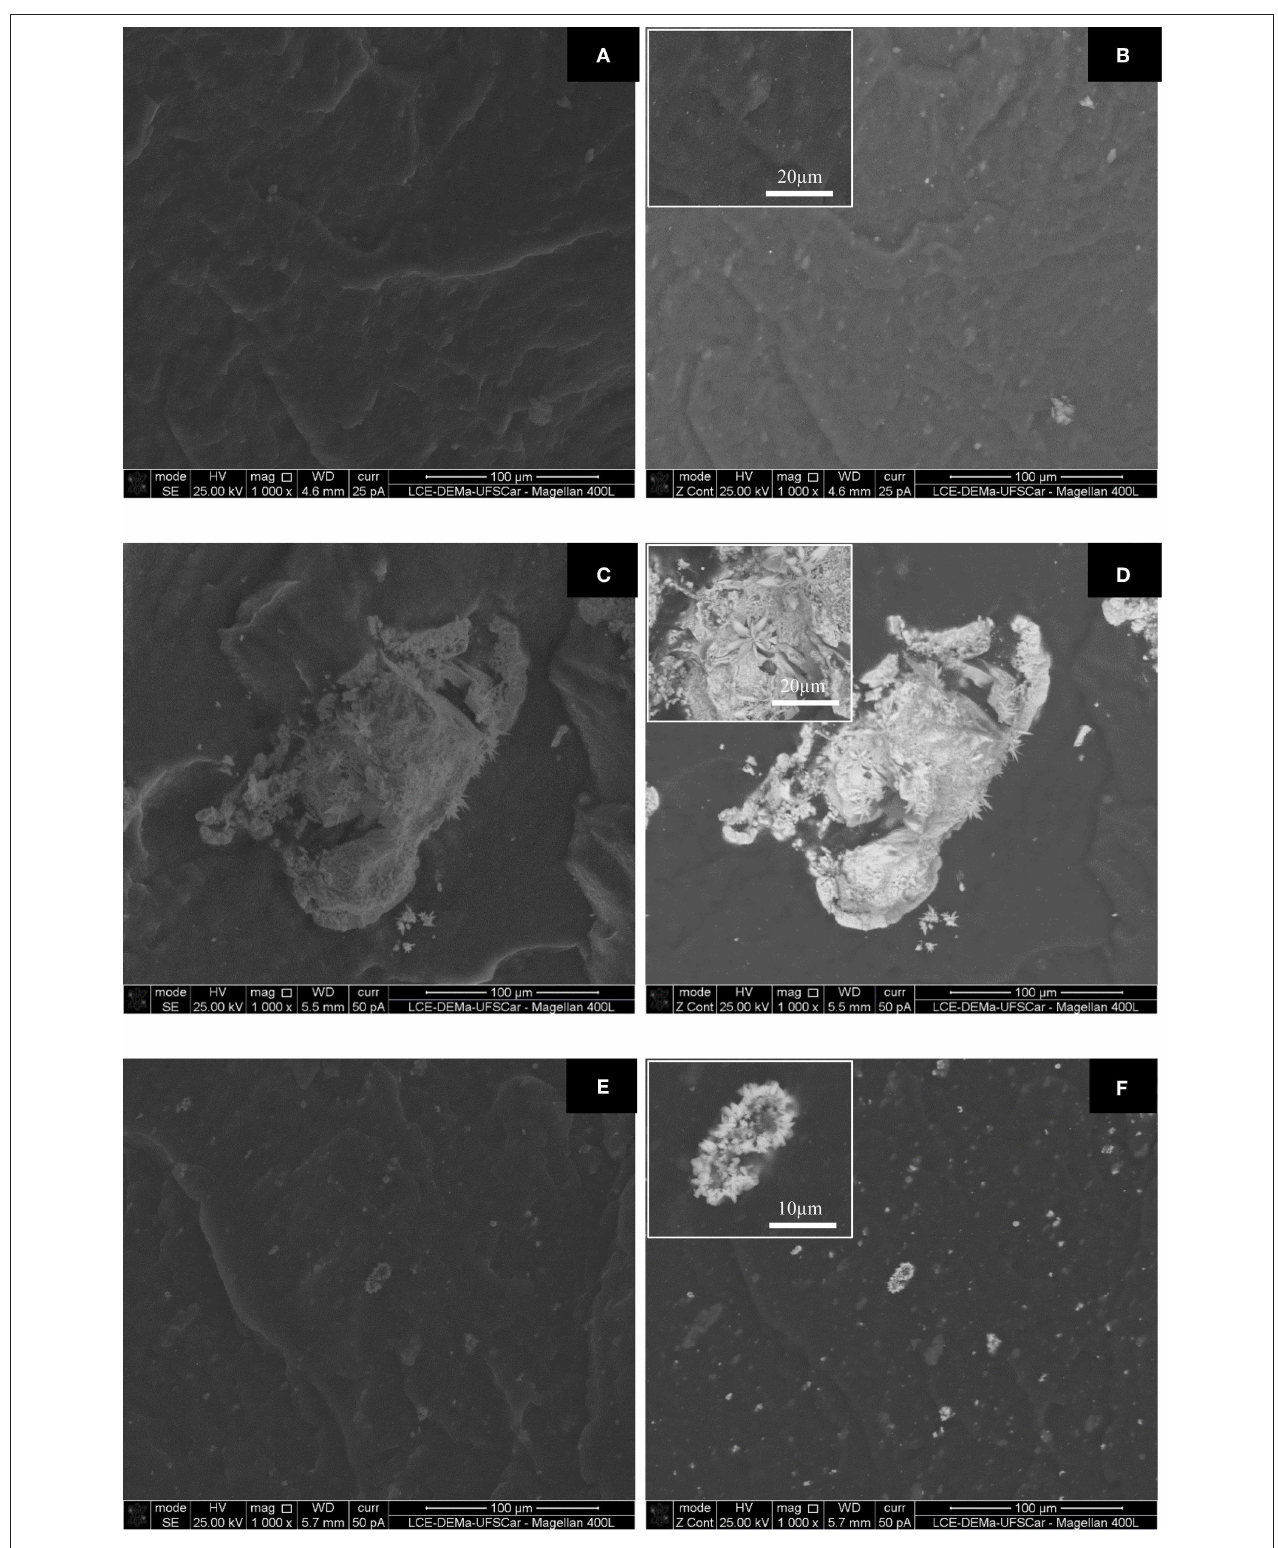
FIGURE 2 | SEM fracture morphology of NBR with 10 wt.% of (A,B) PPy-OMt, (C,D) PPy-Ag, and (E,F) PPy-Ag-OMt. (A,C,E) are images of secondary electrons and (B,D,F) are images of backscattered electrons.